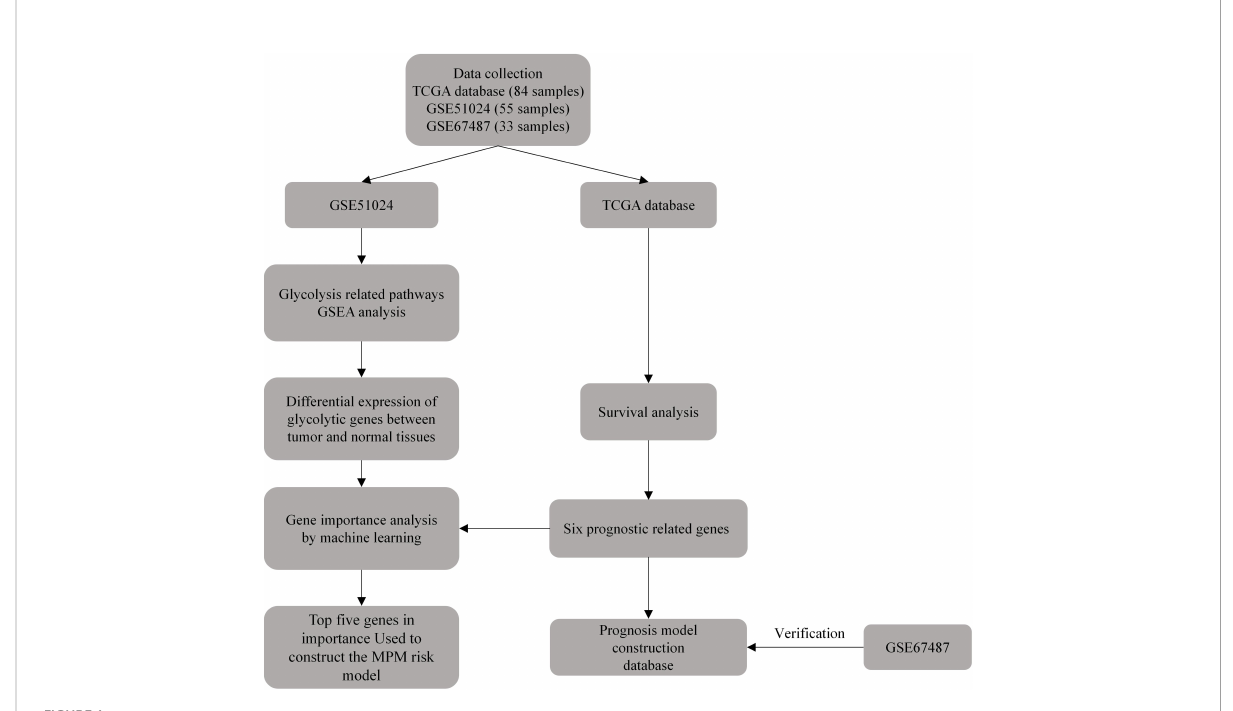
FIGURE 1 Schematic diagram of the fl ow of this